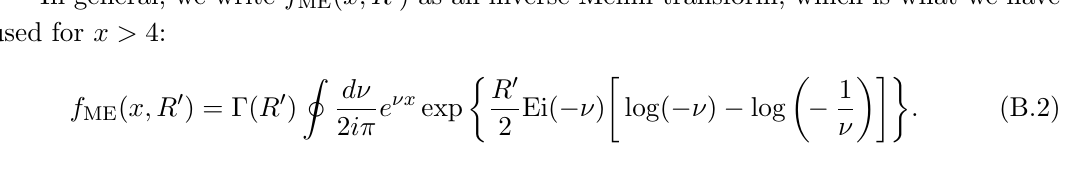
Figure 11 . (cid:28) 21 distributions at O ( (cid:11) 2 imations for (cid:28) 2 . See text for